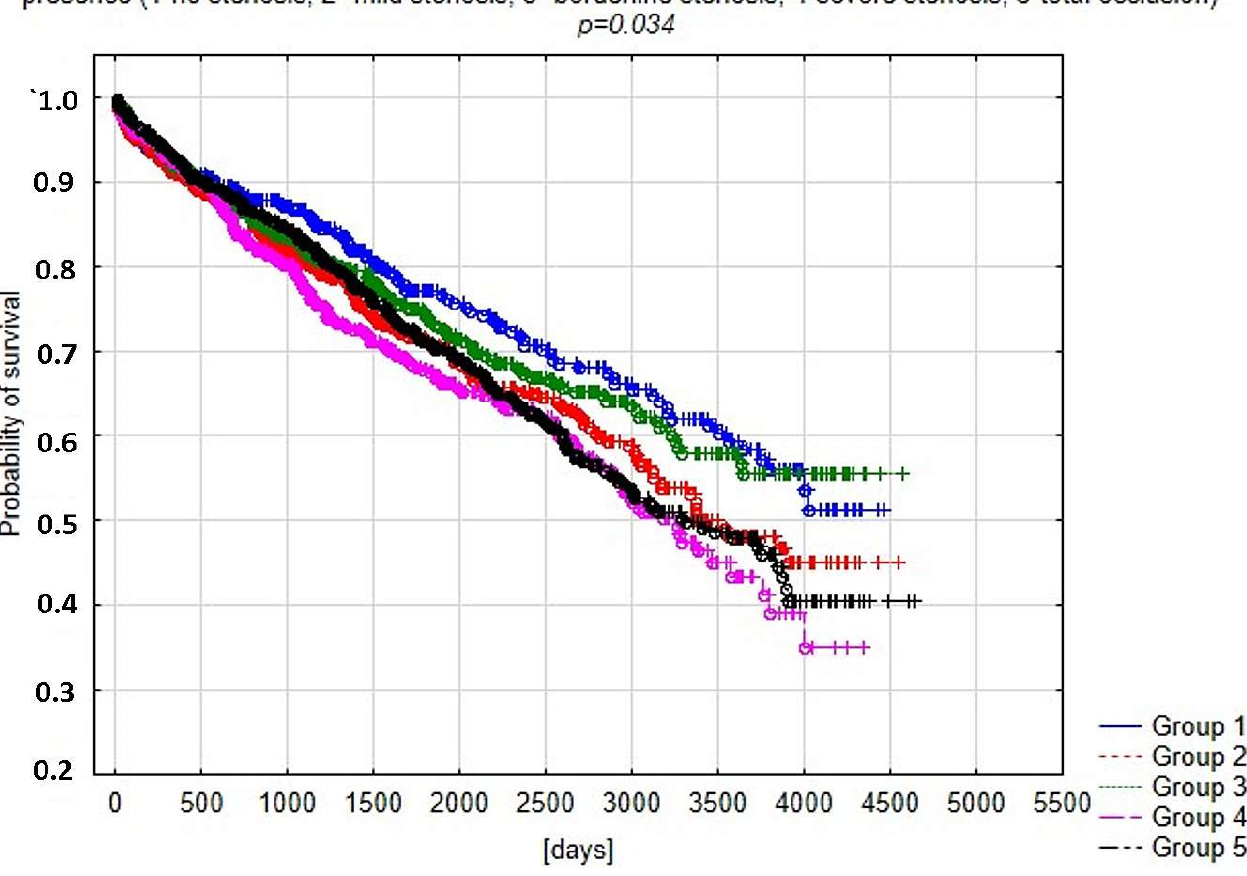
Figure 1. Probability of survival of patients undergoing TLE depending on the degree of LRVSO.